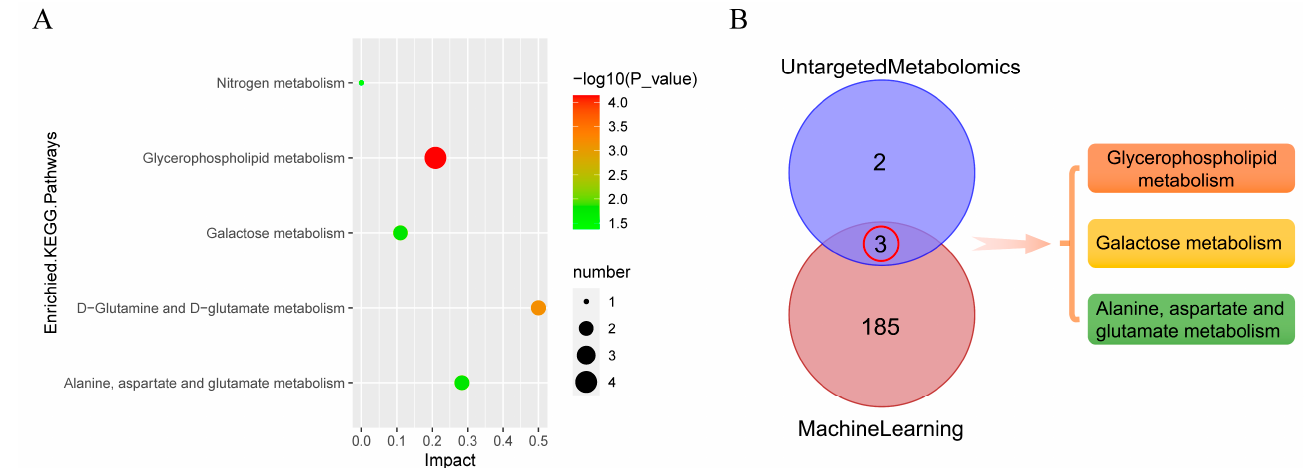
Figure 8. Metabolic pathway analysis. ( A ) The KEGG pathway bubble plot of significant differential metabolites. ( B ) The pathways co-enriched by bioinformatics analysis and metabolomics analysis.